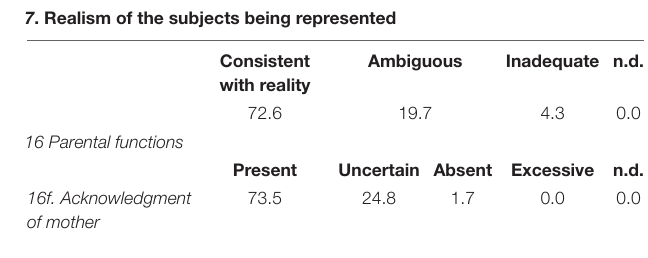
TABLE 2 | Indicators showing the most polarized